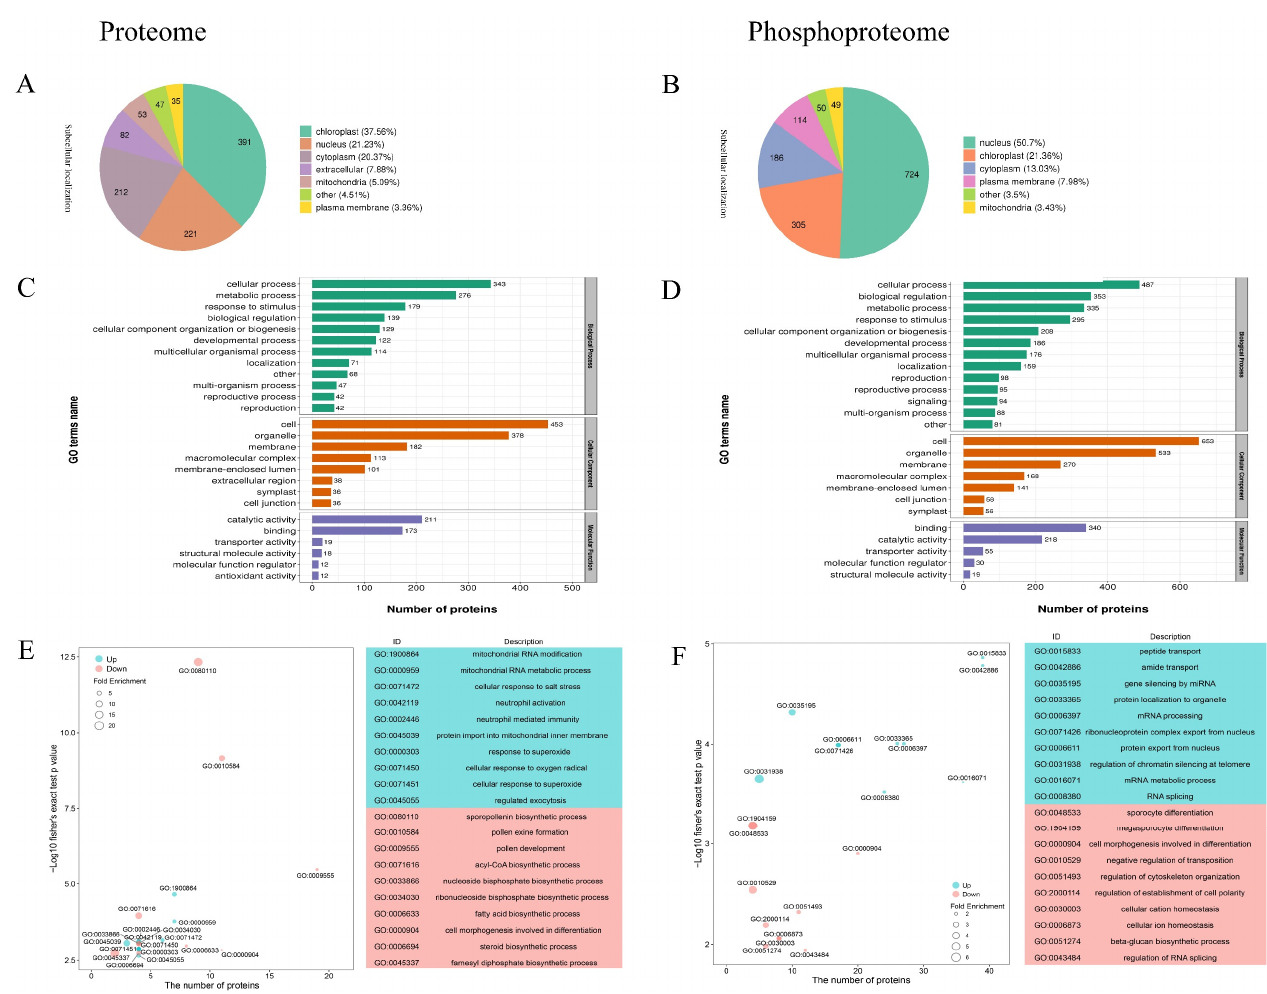
Figure 3. Analysis of the proteome and phosphoproteome data. Subcellular localization prediction and classification statistics of differentially expressed ( A ) proteins and ( B ) phosphosites. GO enrich- ment analysis of differentially expressed identified enrichment among categories of BP, MF, CC in the proteome ( C ) and phosphoproteome data ( D ). GO-BP classification was analyzed for differential protein ( E ) and phosphoprotein ( F ) enrichment. The pathway names are shown along the vertical axis, the horizontal axis represents the enrichment factor, the sizes of dots in the pathway represent the number of DAPs, and the p -value is reflected by the color of each dot.